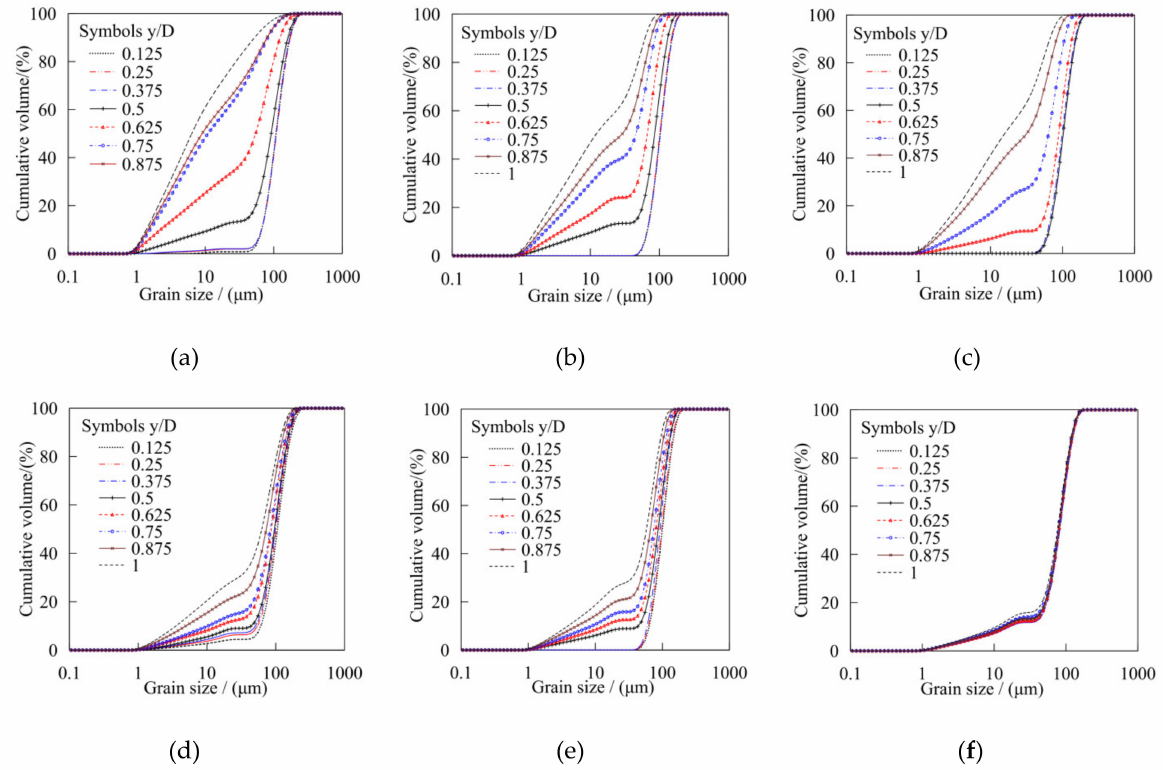
Figure 13. Sediment sorting with different sediment concentrations: ( a ) Q = 10.2 m 3 /h; C = 9.19%; ( b ) Q = 10.02 m 3 /h; C = 13.02%; ( c ) Q = 9.87 m 3 /h; C = 17.15%; ( d ) Q = 20.43 m 3 /h; C = 13.24%; ( e ) Q = 20.45 m 3 /h; C = 17.15%; and ( f ) Q = 20.72 m 3 /h; C =